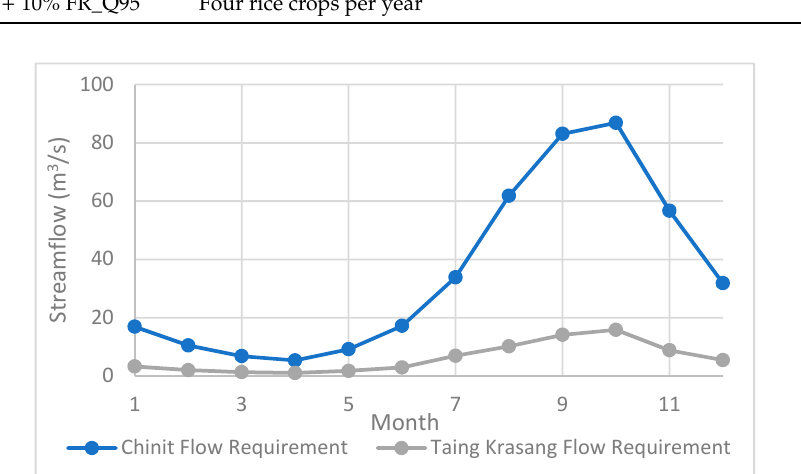
Figure 7. Monthly streamflow requirements downstream of irrigation schemes.